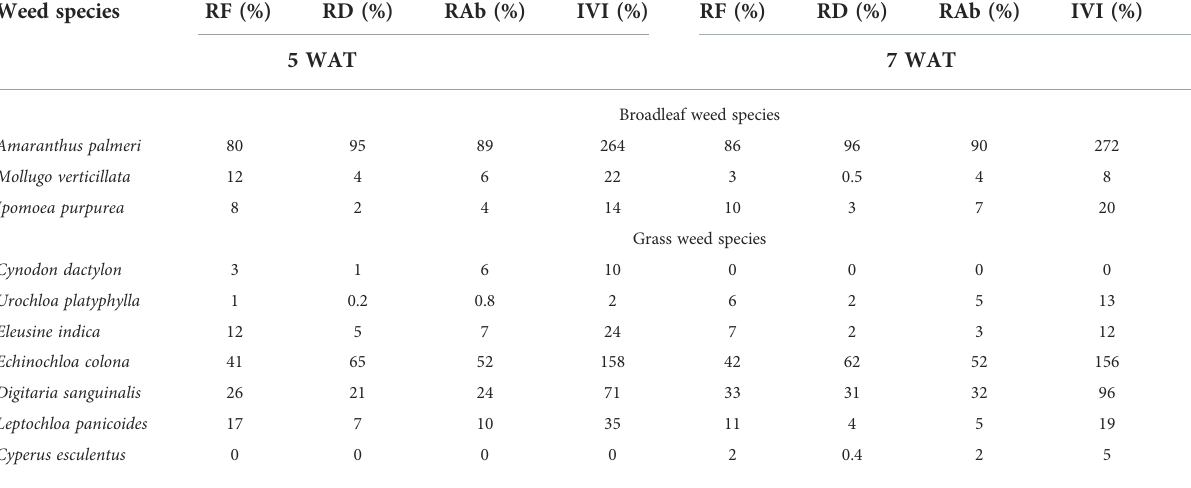
TABLE 6 Relative frequency (RF), relative density (RD), relative abundance (RAb), and importance value index (IVI) at 5 and 7 weeks after transplanting (WAT) in weedy plots with sweetpotato in Kibler, AR, 2021. Weed species